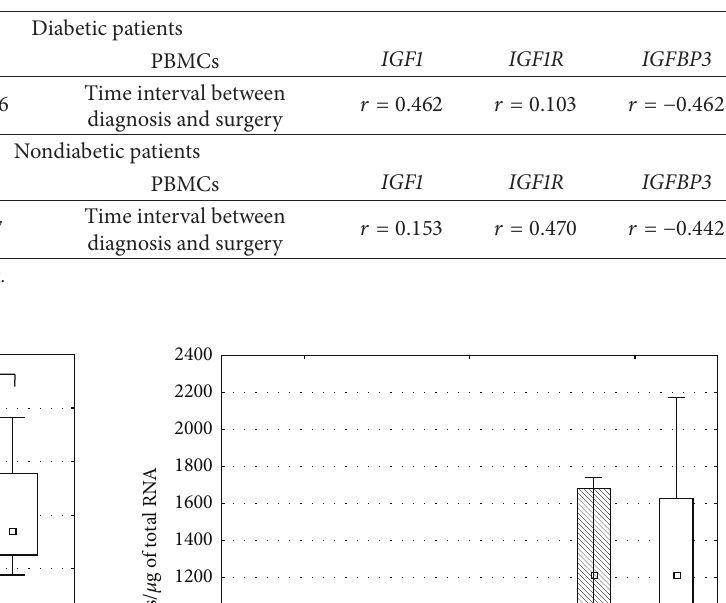
Table 3: The correlations between relative expression of IGF1 , IGF1R , and IGFBP3 and time interval between diagnosis and surgery in the ERMs and PBMCs of diabetic and nondiabetic patients.